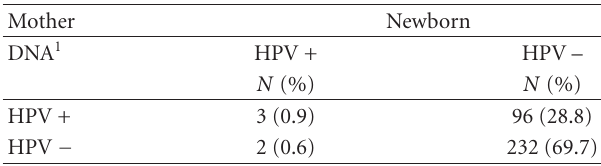
Table 4: Concordance between mother and newborn for HPV DNA 1 ( N =